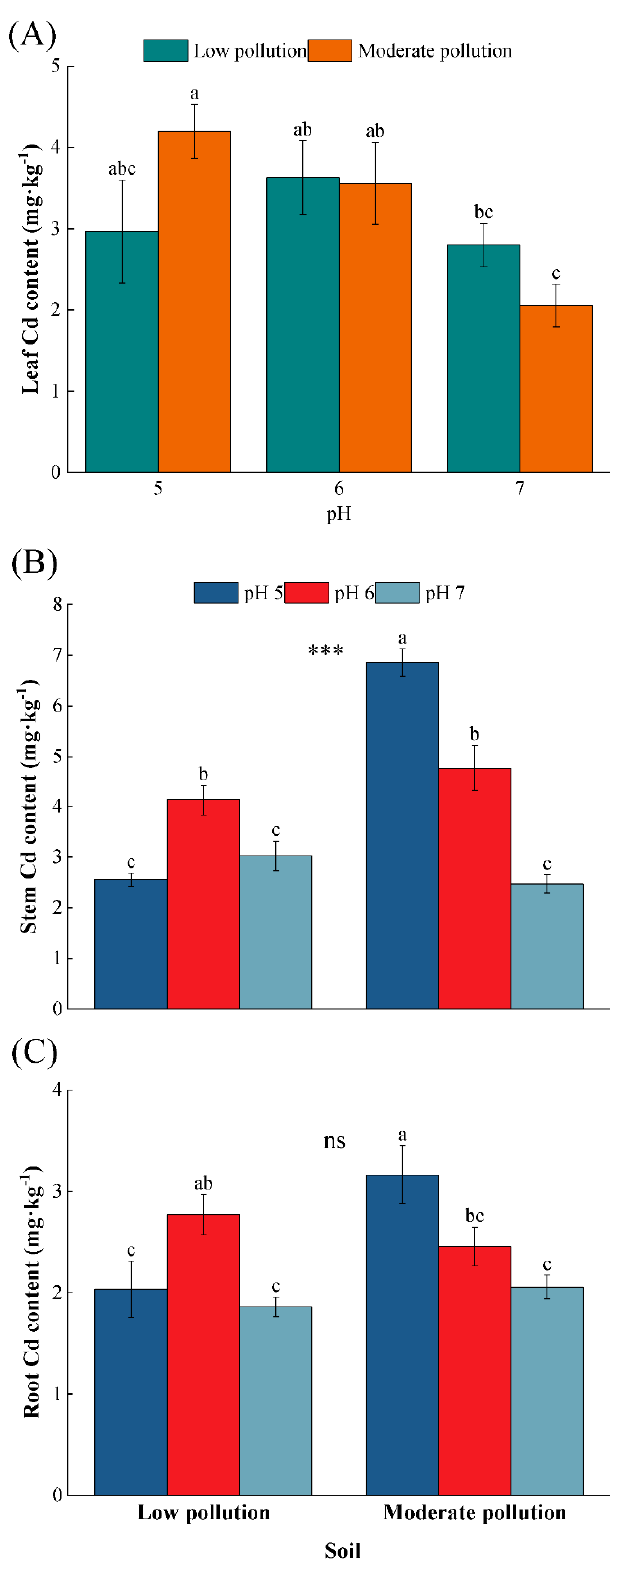
Figure 2. Cadmium (Cd) contents in leaves ( A ), stems ( B ), and roots ( C ) of Polygonum hydropiper growing under three soil pH values at two Cd pollution levels. Different lowercase letters (a, b, c) indicate significant differences among different treatments. The * and ns symbols indicate differences between two soil Cd levels (*** p < 0.001, ns p > 0.05).